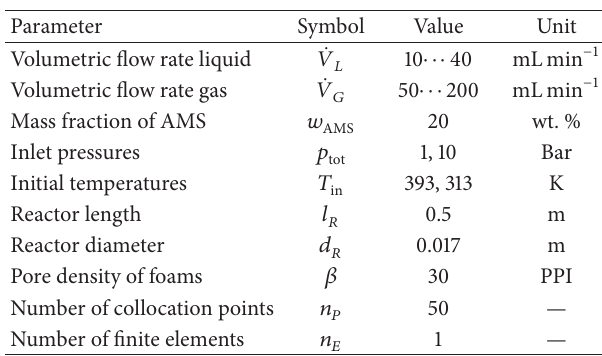
Table 1: Simulation parameters.